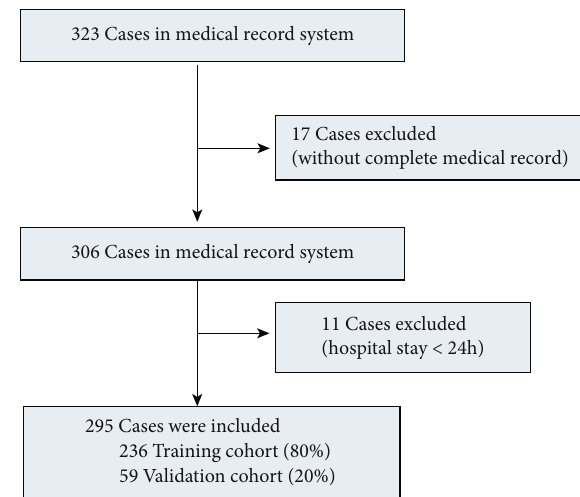
Figure 1: Flowchart of patient recruitment in the internal